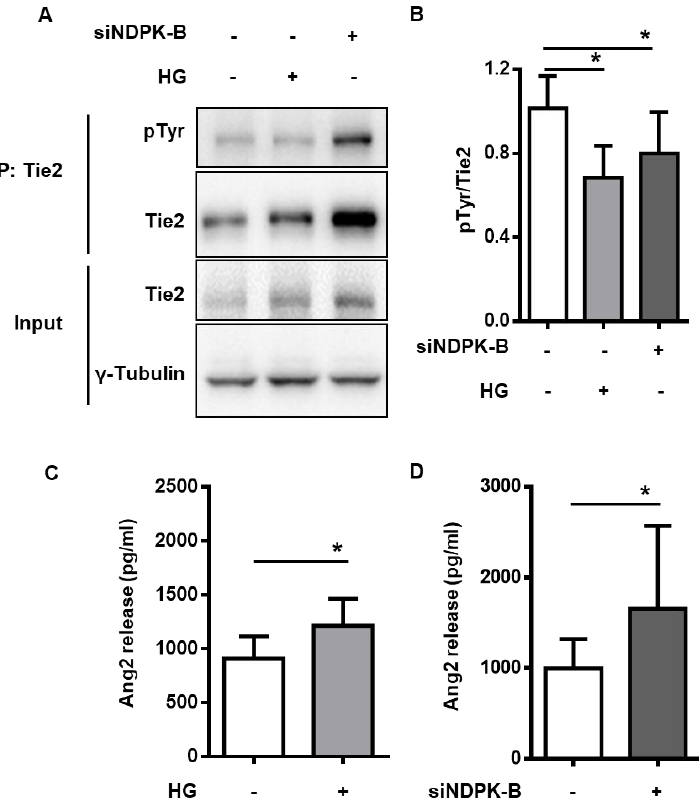
Figure 4. NDPK-B depletion and HG treatment reduce Tie2 phosphorylation due to elevated Ang2 secretion. HUVECs were transfected with either scrambled control ( − ) or siRNA against NDPK-B (siNDPK-B, +) or treated for 15 min without (− ) or with HG (+) if indicated. ( A ) Representative immunoblots of tyrosine phosphorylation (pTyr) of Tie2 after immunoprecipitation (IP); Tie2 and γ -Tubulin content in whole-cell lysates (Input) are also shown. ( B ) Quantification of Tie2 phosphorylation relative to the total amount of precipitated Tie2 ( n = 3). HUVECs were transfected with either scrambled control ( − ) or siRNA against NDPK-B (siNDPK-B, + ) or treated for 24 h without ( − ) or with HG) ( + ). Quantification of secreted Ang2 in the supernatant of HG-treated ( C , n = 7) and NDPK-B depleted ECs ( D , n = 5) by ELISA * p < 0.05.